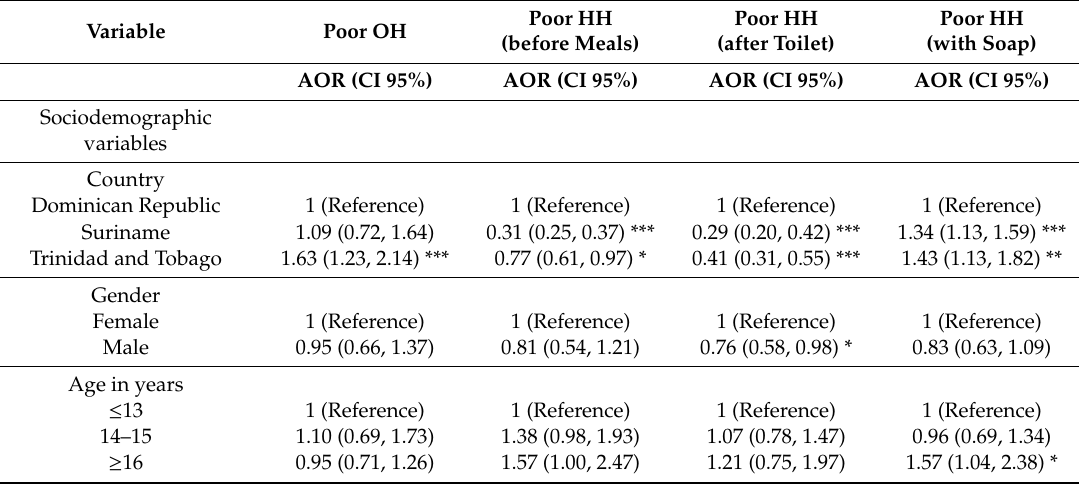
Table 2. Associations with poor oral hygiene (OH) and poor hand hygiene (HH)